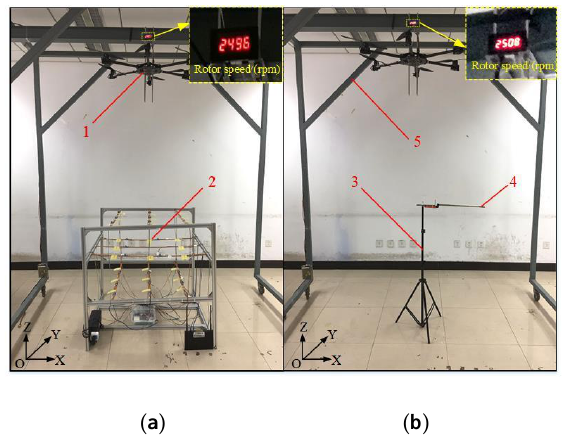
Figure 9. Test arrangement of test platform for rotorcraft UAV and flexible detection structure acquisition system. ( a ) System test platform; ( b ) Wind speed sensor node installation; 1 = Multi-rotor UAV platform; 2 = Flexible detection structure acquisition system equipment; 3 = Triangle bracket; 4 = Wind speed sensor probe; 5 = Mobile bracket. Table 2. Technical parameters of multi-rotor unmanned aerial vehicles